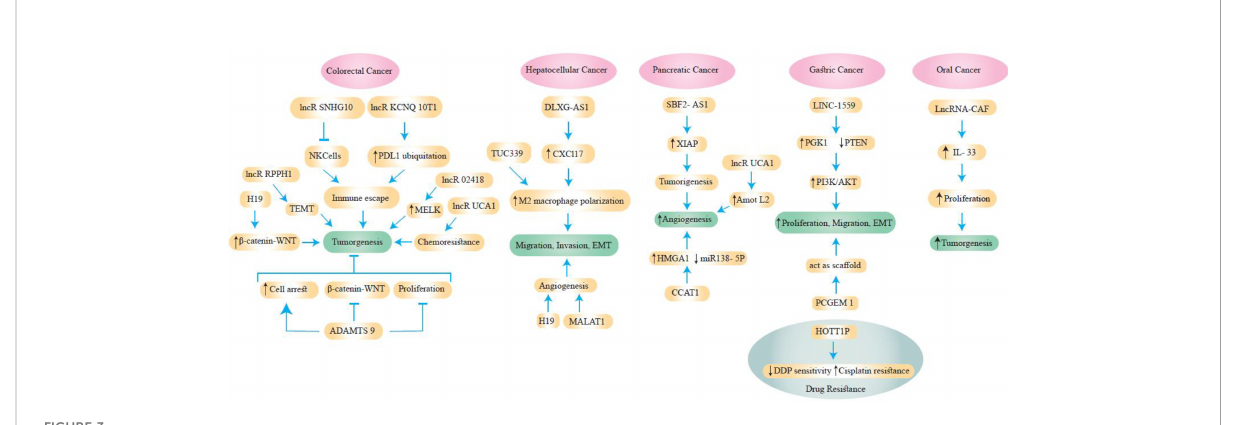
FIGURE 3 Some lncRNAs are involved in the pathogenesis of GI